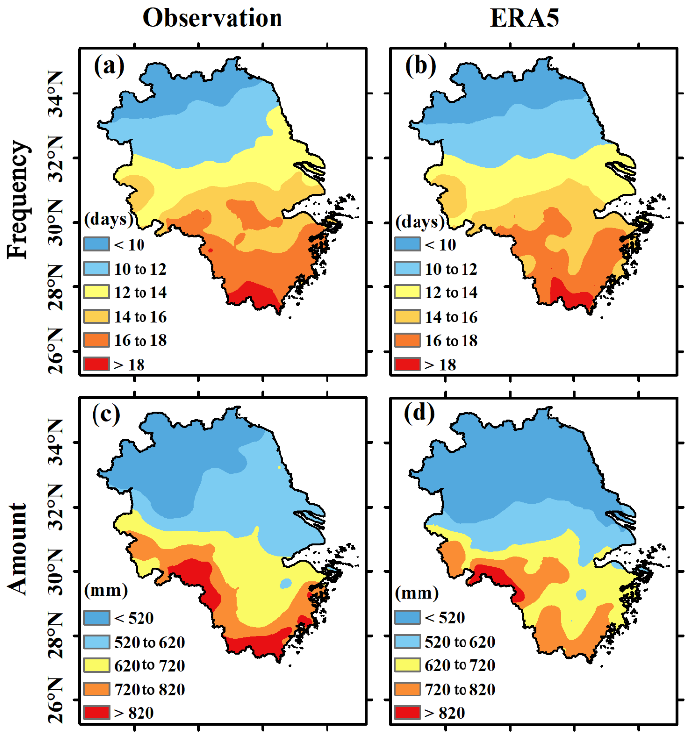
Figure 4. Spatial distribution of annual mean extreme precipitation days ( a , b ) and amount ( c , d ) in the YRD for the period 1961–2018.